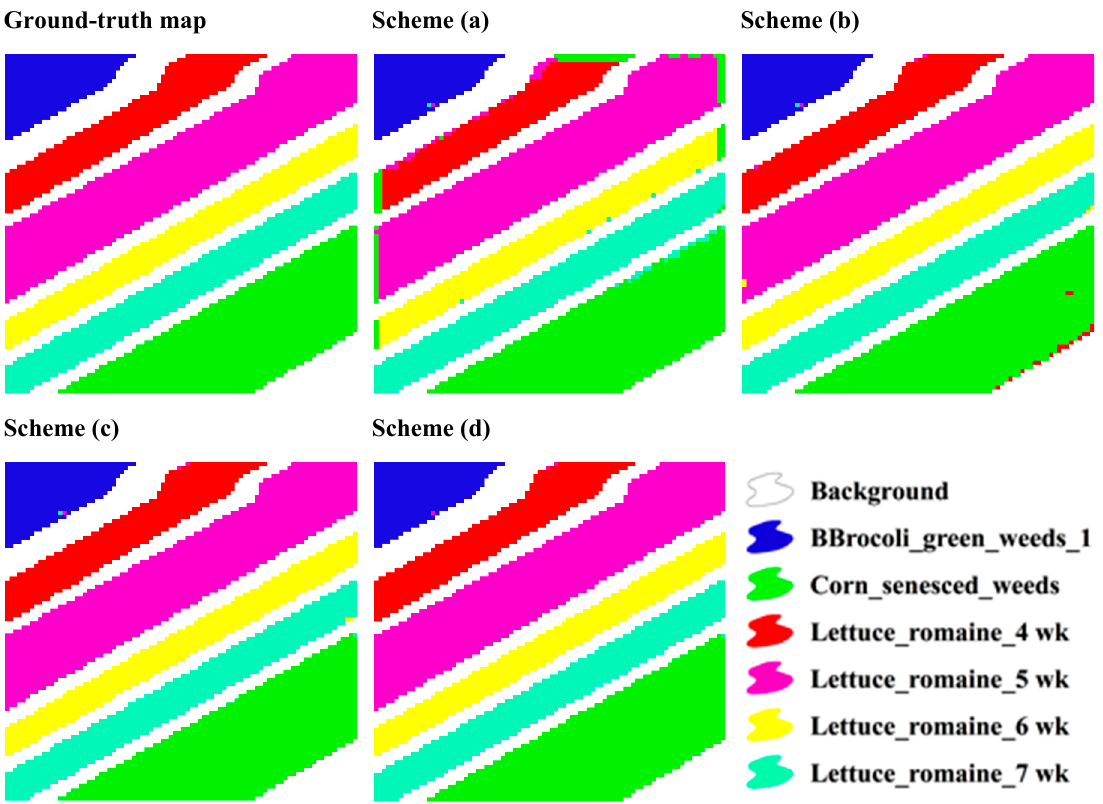
Figure 11. Classification results of the HDCA for the Salinas-A scene. Scheme ( a ) 1% ( b ) 5%, ( c ) 10%, ( d ) 12.5% of the training samples of each class were used to classify the reference datasets.